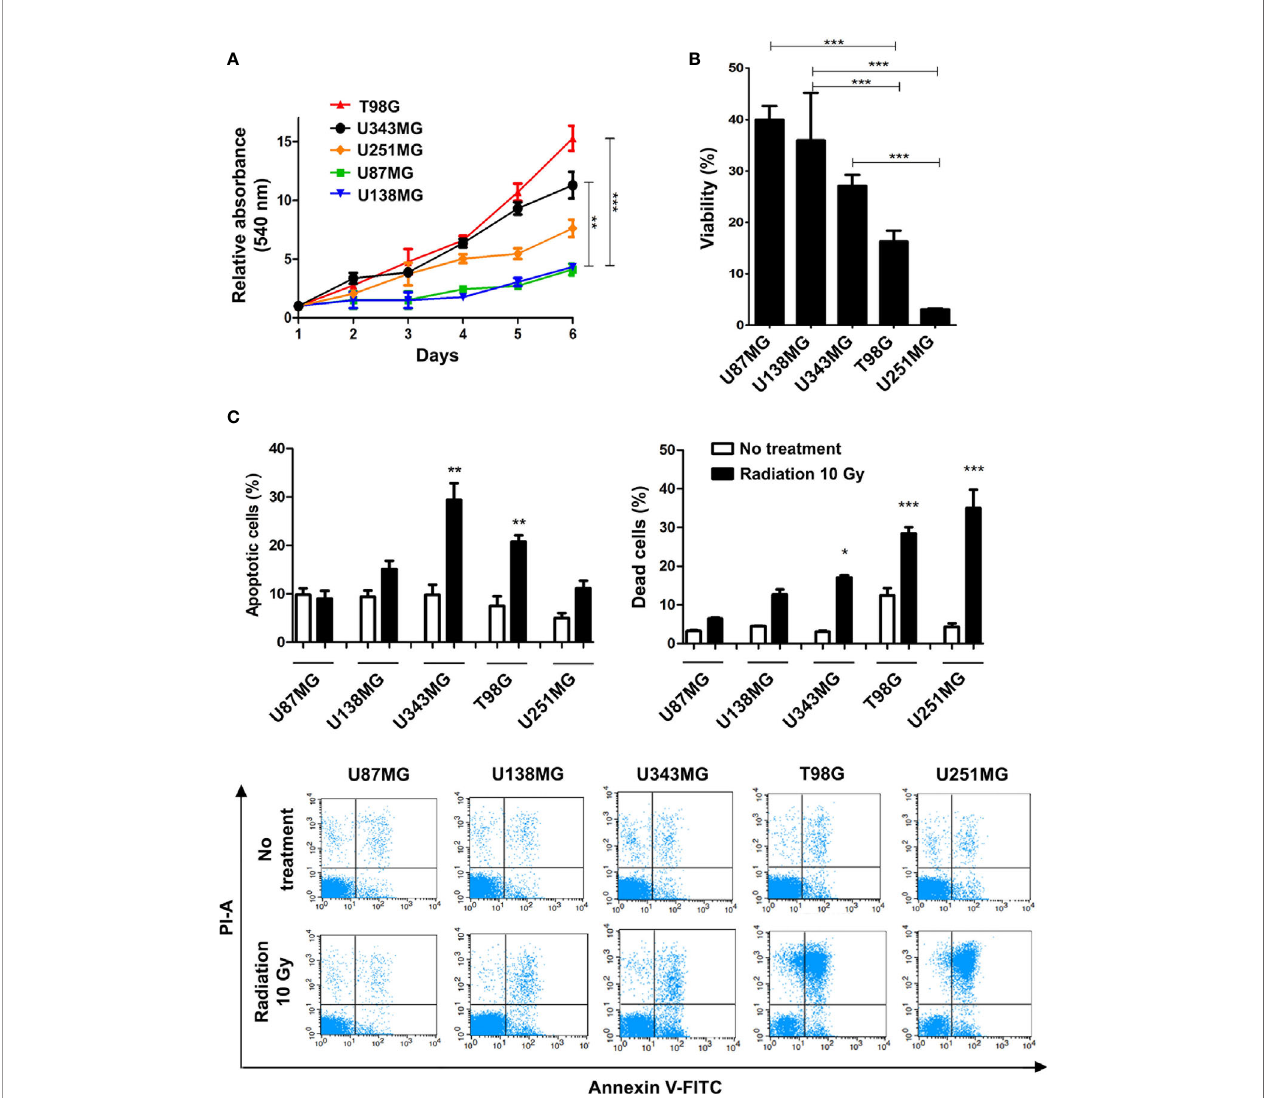
FIGURE 1 | Proliferation and ionizing radiation resistance analysis in GBM cell lines. (A) Proliferation assay of T98G, U343MG, U251MG, U87MG, and U138MG. (B) Cytotoxicity assay of GBM cells after radiation treatment. (C) Quanti fi cation of apoptosis and cell death of GBM cells after irradiation are shown in the upper graphics and representative images of fl ow cytometry experiments are presented in the lower panel. Error bars represent the SEM of 3 independent experiments. Graphs were plotted with GraphPad Prism 4.0 software. *p < 0.05, **p < 0.001, and ***p <